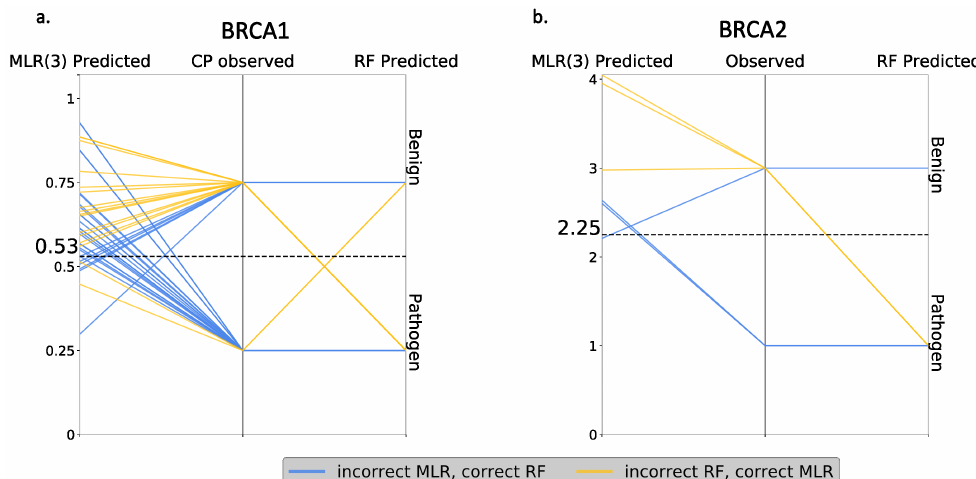
Figure 11. Variant-level description of the discrepancies between the endophenotype-based pathogenicity predictions and RF. In ( a , b ), we have the same plot for BRCA1 and BRCA2, respectively. The three vertical lines in each plot represent, from left to right, the following: the values of the endophenotype estimates (obtained with MLR), the actual pathogenic natures of the variants (benign-top/pathogenic-bottom) and the RF predictions for the variants. In this representation system, each variant is characterized by a triplet, e.g., (0.75, Benign and Pathogen); these values are united by a line, which, in our example, would go from 0.75 (first axis) to Benign (second axis) to Pathogen (third axis). We display only the lines for the variants for which MLR was successful and RF failed (yellow) and vice versa (blue). The dashed line indicates the functionality threshold for the HDR assay.